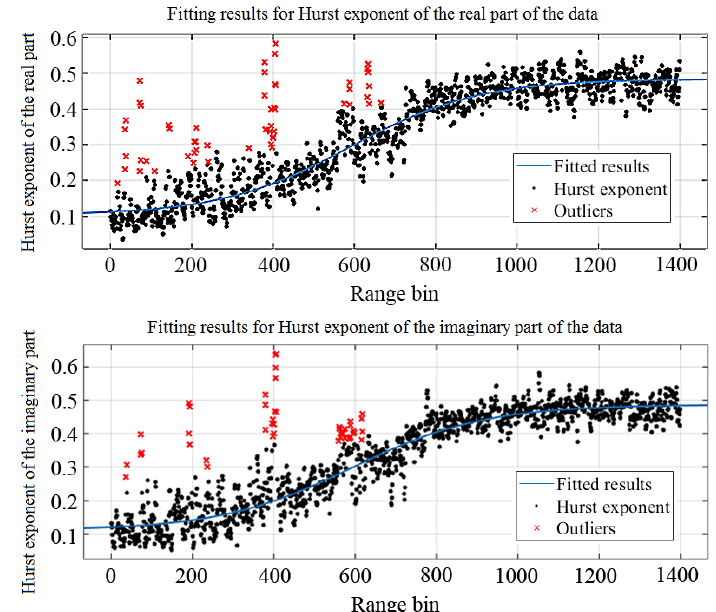
Figure 4. Fitting results with modified Sigmoid function.